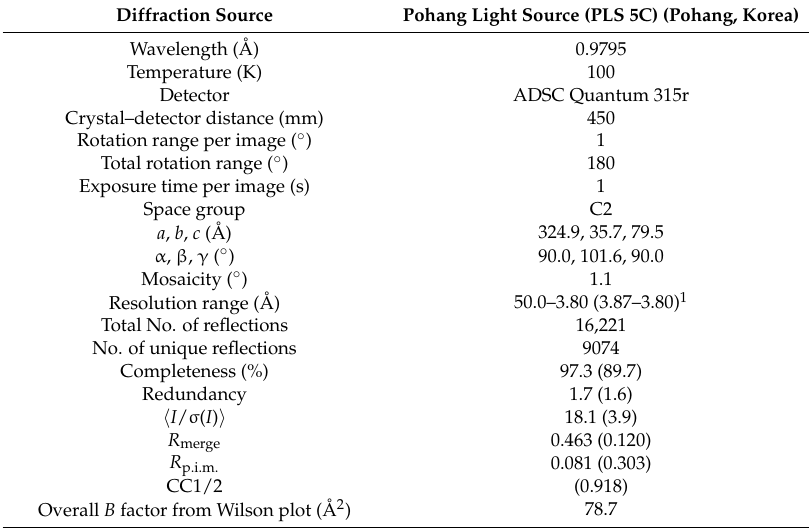
Table 3. Data collection and